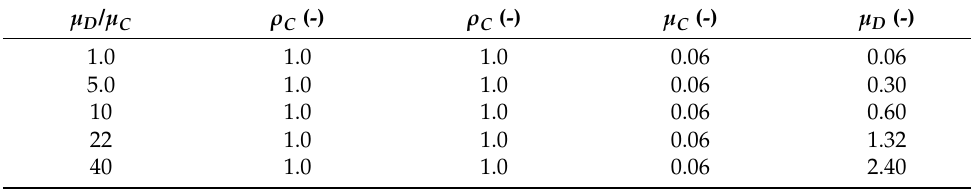
Table A1. Parameter settings (densities and viscosities) corresponding to the simulated cases (see Table 1) in the dimensionless units used in the code. The dissipation rate of TKE (averaged over space and time) is 3.07 ( - ), and the initial drop diameter is 2 ( - ). The length of the simulation domain is 2 π